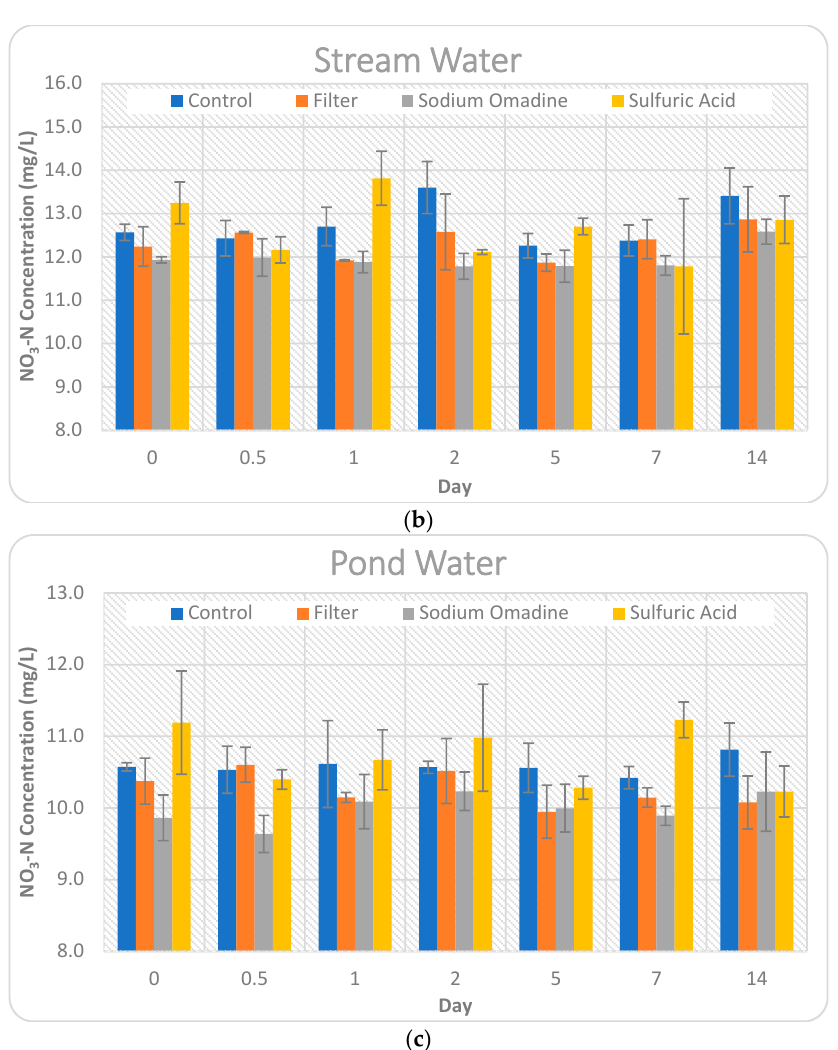
Figure 3. Comparison of the impact of the four preservation methods on nitrate-N concentrations for Day 0–14. Error bars represent +/ − one standard deviation from the mean. Note the y -axis values are not the same for each water source for visual clarity. ( a ) Tile water; ( b ) Stream water; ( c ) Pond water. Table 3. Daily high and low temperature that water samples were exposed to, as well as the nitrate- N concentrations and % change from the baseline concentration. The baseline concentration is the Day 0 Control for each water source.